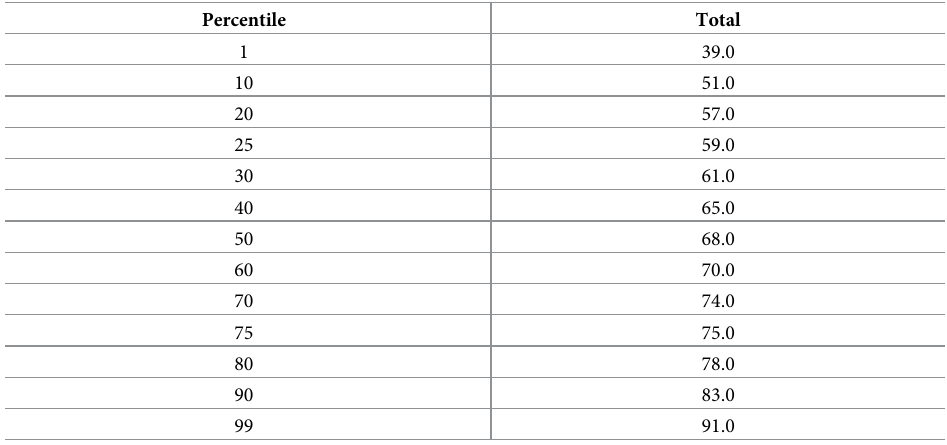
Table 6. Description of the GSAM